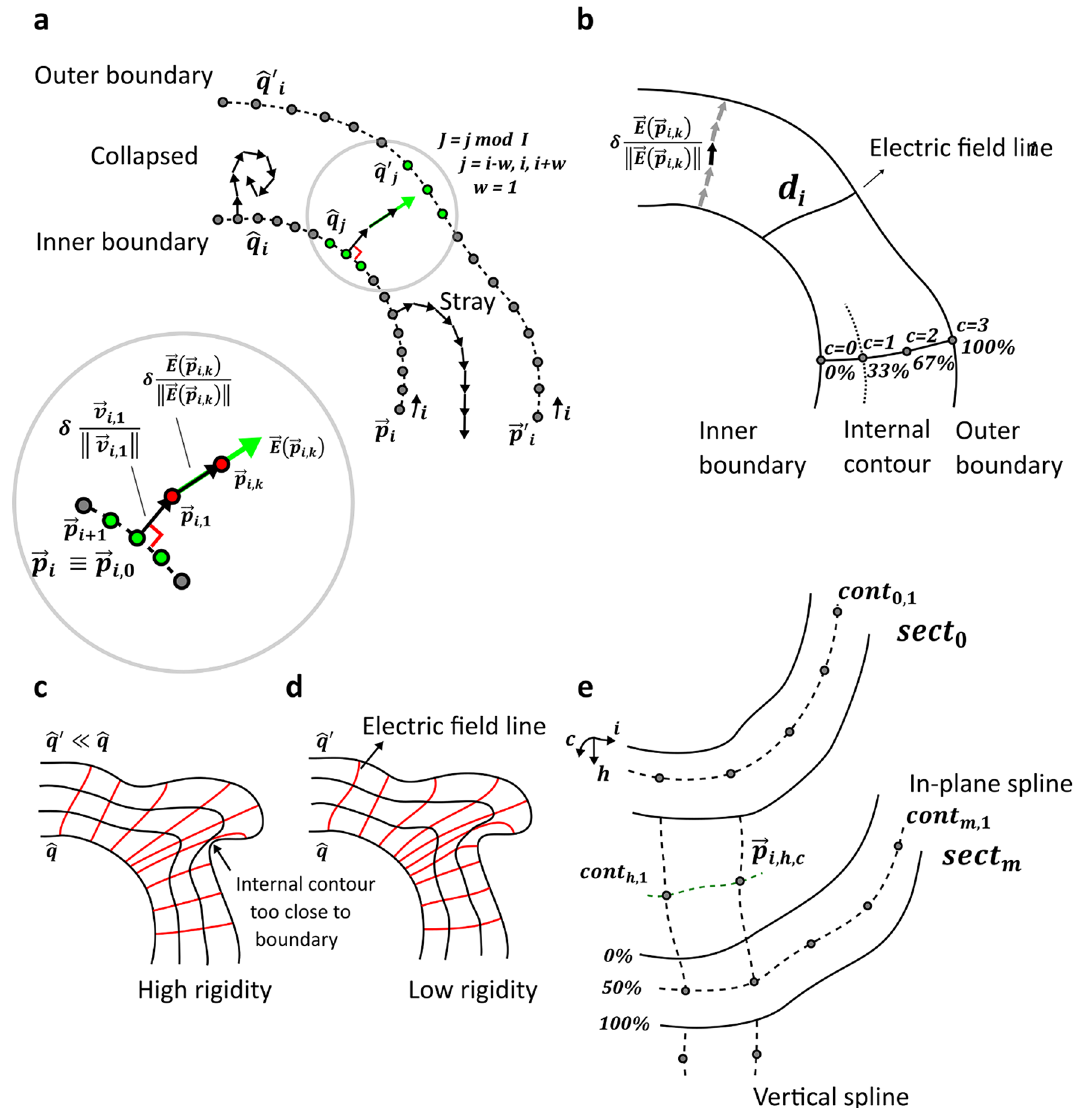
Figure 2. Generation of 3D cycloramas through electrostatic fields. ( a ) Boundary contours are defined on the deformed tube boundaries as sequences of charged points (cid:31) p i and � p ′ i . Each electric field line is built up � v i ,1 incrementally starting at point � p i ≡ � p i ,0 . The first increment δ · �� v i ,1 � is normal to the inner boundary. Each ) � E ( � p i , k is defined as the direction of the electric field scaled by δ (electric field line subsequent increment δ · ) (cid:31) � E ( � p (cid:31) i , k (cid:31) (cid:31) ) � E ( � p , considering charges on both i , k − 1 segment size), computed at the tip of the previous increment δ · ) (cid:31) � E ( � p (cid:31) i , k − 1 (cid:31) (cid:31) boundaries in a user-defined window (green points ). This process might fail to connect point (cid:31) p i to the outer boundary, resulting in ‘collapsed ’ or ‘stray ’ lines, which are identified and removed in our cyclorama method. ( b ) The local thickness is defined as the length d i of field line i . Intermediate contours cont h , c are defined on a total of · 100% ( c = 0, 1, . . . , C − 1 ). ( c ) Stiff field lines (high rigidity ) do not properly follow C relative depth levels c C − 1 the curvature of the outer boundary. ( d ) Lower rigidity results in more flexible field lines, pushing the intermediate contours away from the boundaries. ( e ) The process shown in a-d is performed on every m th section of the image stack. The remaining contours cont h , c on sections sect h ( h = 0, m , 2 m , . . . ) are generated by fitting vertical cubic splines. This figure was created with Inkscape 14 the (virtual) 2D electric field lines within the enclosed space described by those boundaries as shown in Fig. 2. The theory governing electrostatic fields 38 ensures that electric field lines never cross and that they never form closed loops (they always start at one boundary and cross the tube to reach the other boundary). Moreover, the electric field lines are always perpendicular to the charged boundaries. These properties make the electric field lines an ideal tool for the definition of the relative local 2D thickness, which we define here as the length d i of the respective electric field line i , spanning the inner and outer boundary of the tube’s cross section (see Fig. 2b).